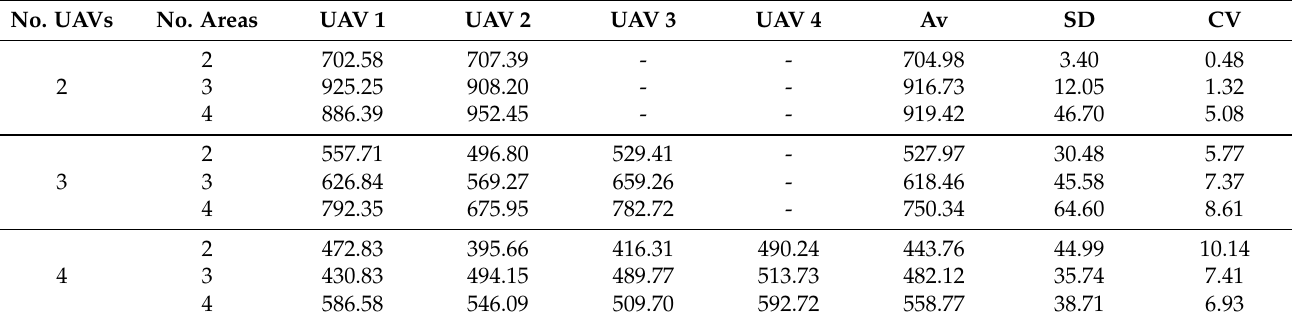
Table 1. Distance results for multiple UAVs and multiple areas to explore.